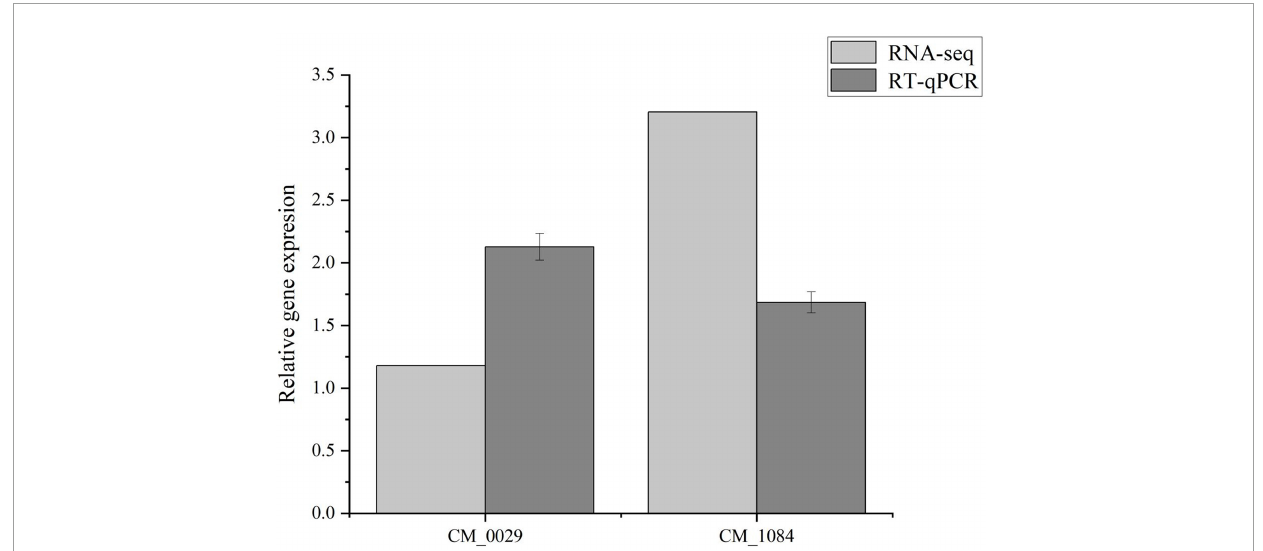
FIGURE5 Validation of two DEGs in RNA-Seq using RT-qPCR. The different letters represent significant differences among treatments according to Duncan’s multiple range tests ( p < 0.05), the same letters represent no significant differences among treatments. Data are represented as means ± SD, n = 3. The experiment was performed three times with similar